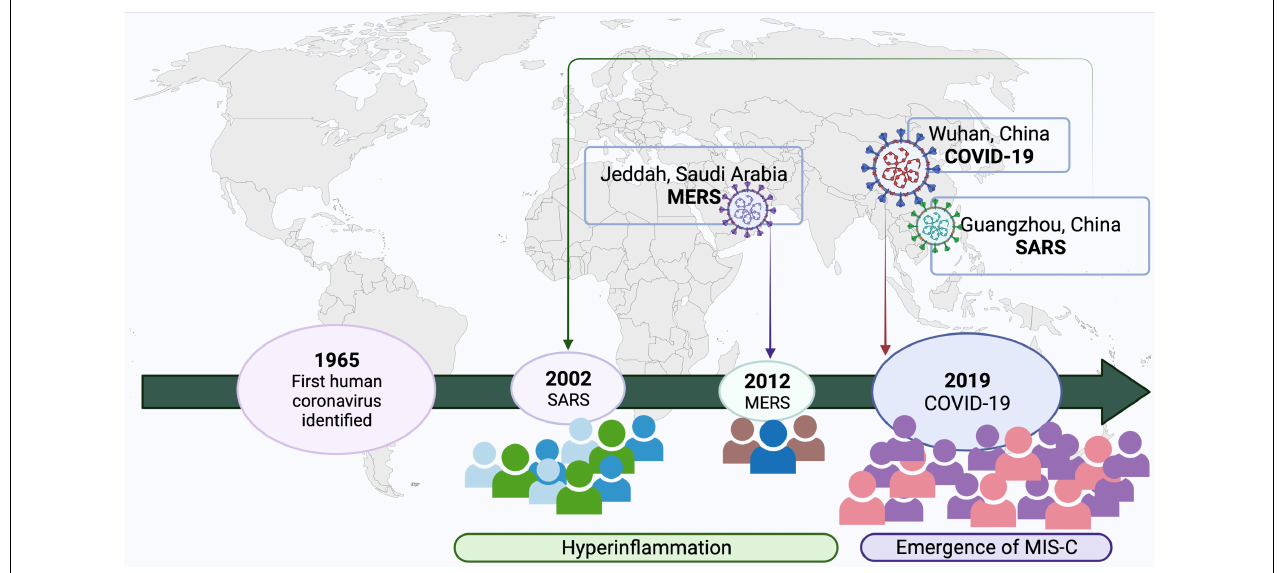
FIGURE 2 | Emergence of coronavirus in humans and relationship with KD-MISC spectrum. Created with BioRender.com.